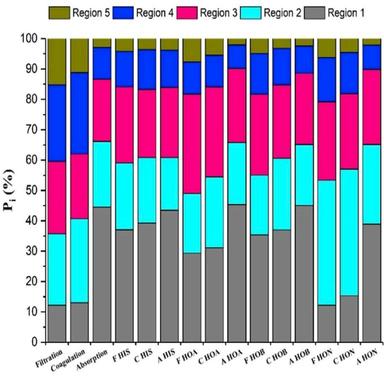
FRI distribution for filtration, coagulation and absorption effluent with different hydrophilicity/hydrophobicity (F-filtration process, Ccoagulation process, A-adsorption process, RAW-the raw bio-treated coking wastewater, HOA-hydrophobic acid, HOB-hydrophobic base, HON-hydrophobic neutral, HIS-hydrophilic substances, Pi stands for the proportion of region i, i = 1, 2, 3, 4, 5).